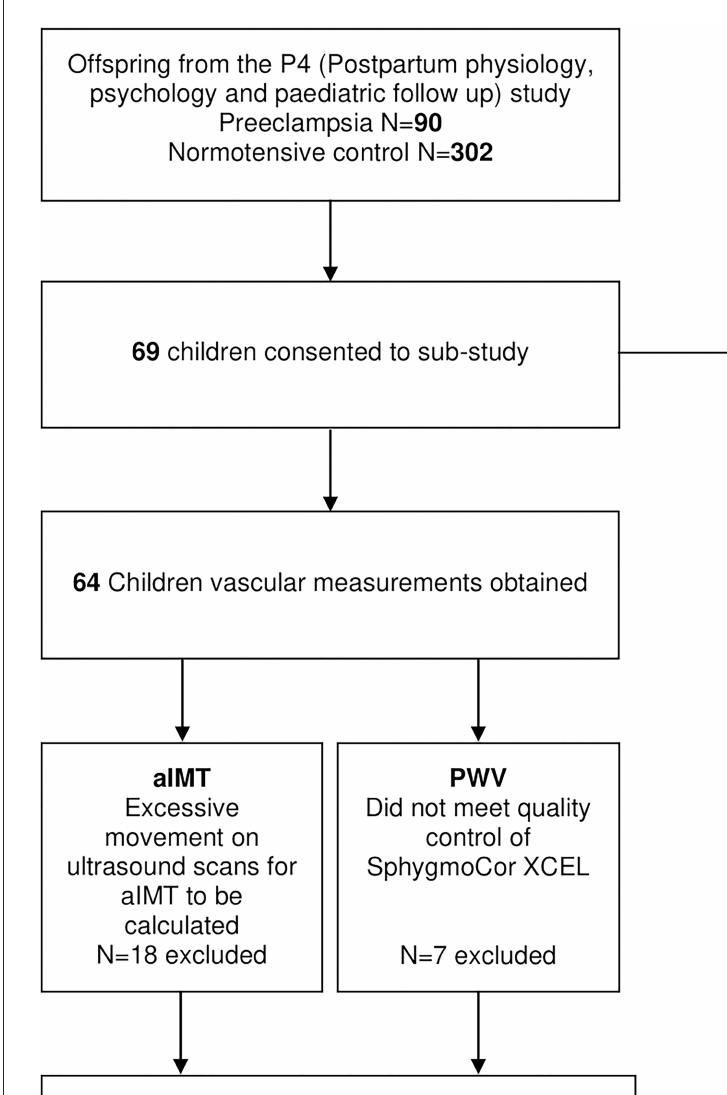
antihypertensive medication (60% vs. 0%) and exercised more at 6 months (2 vs. 1 days). Otherwise, characteristics of mothers were not different. Mothers with preeclampsia were classified as early vs. late onset (19% vs. 81%) and severe hypertension preeclampsia vs. non severe (58% vs. 42%).